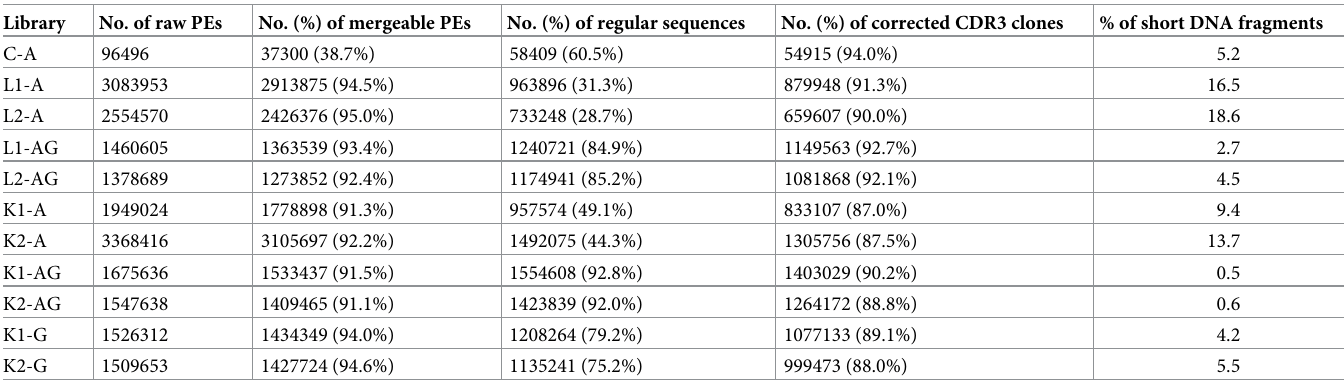
Table 1. Statistics of sequencing data for all libraries.